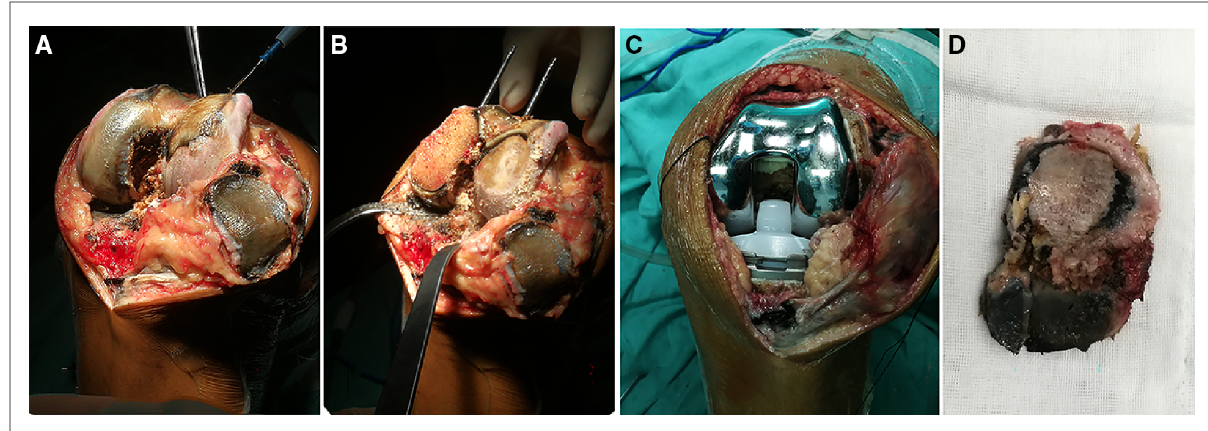
FIGURE 4 ( A – C ) Melanin deposits on articular cartilage during surgery. ( D ) A bone fragment taken during surgery.